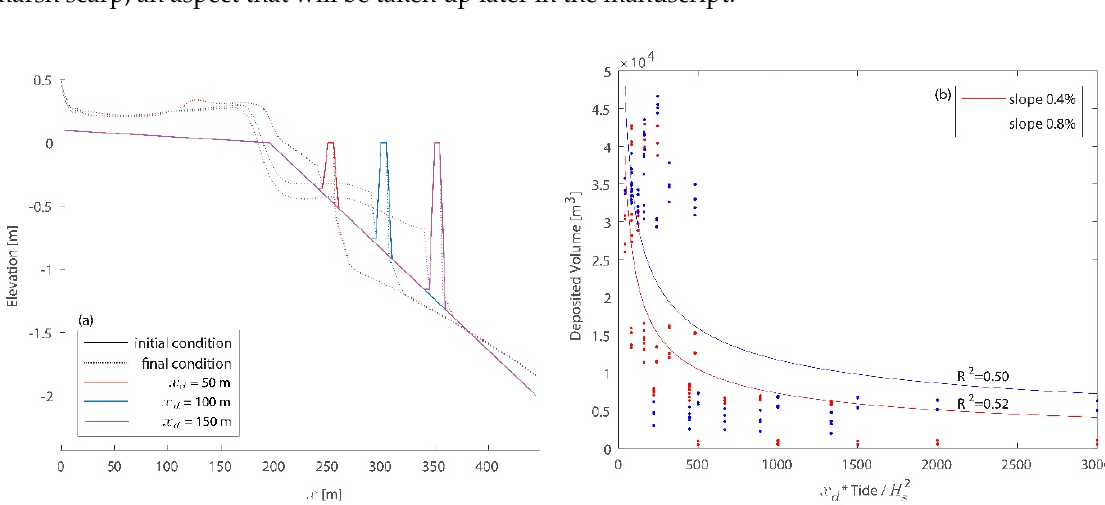
Figure 6. ( a ) Bed level profile after the end of the simulation compared to the initial condition, for the simulation with slope 0.8%, H s = 0.5 m, Tide = ± 0.2 m, C s = 0.2 kg / m 3 and D 50 = 100 µ m. ( b ) Sediment deposition into the salt marsh behind the breakwater, as function of breakwater distance from the shoreline, tide and wave height.